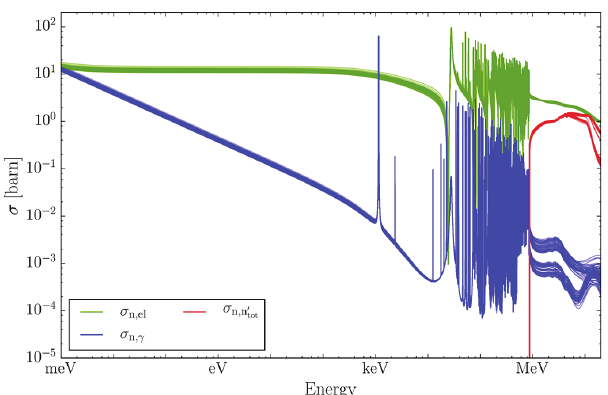
Fig. 8. k eff variation between random cross sections of 54 Fe, histogram (top) and comparison to TMC-Ref (bottom). The columns present the results of TMC-CS (left), TMC-sensi as previously done (middle), and TMC-sensi without the (n, γ ) reaction (right).